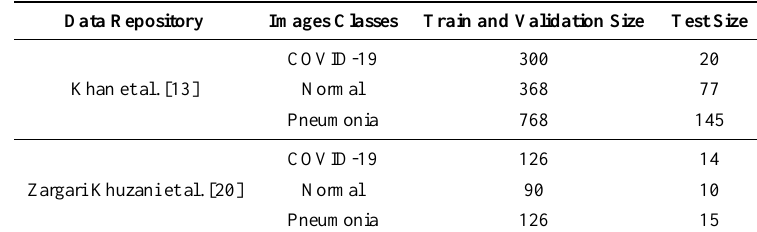
Table 2. Summary of classes and number of images per datasets